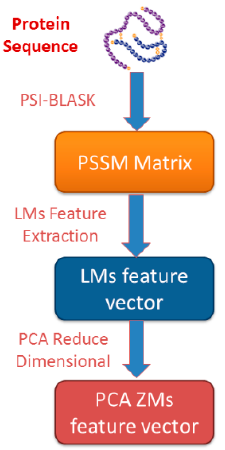
Figure 1. The flowchart of the proposed feature extraction method.